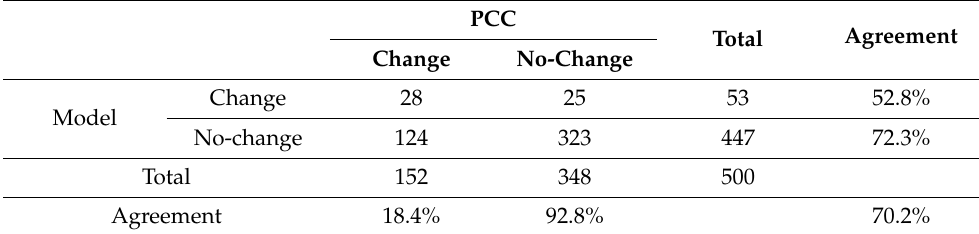
Table 6. Agreement between our model and PCC. Kappa statistic = 0.138. Note, these are not necessarily correctly identified, merely agreement between the two methods.